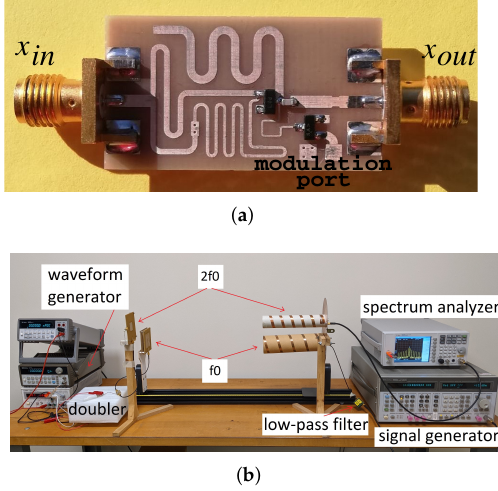
Figure 5. Harmonic transponder for both identification and sensing. ( a ) photo of the frequency doubler prototype with modulation port. ( b ) photo of the wireless experimental setup. Frequency doubler PCB area: 15 × 23mm 2